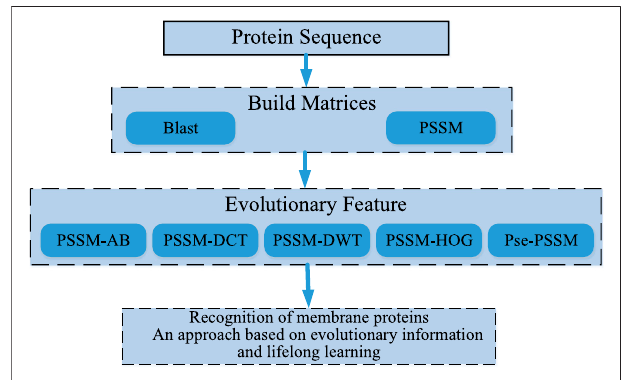
FIGURE 1 | The summary of the main